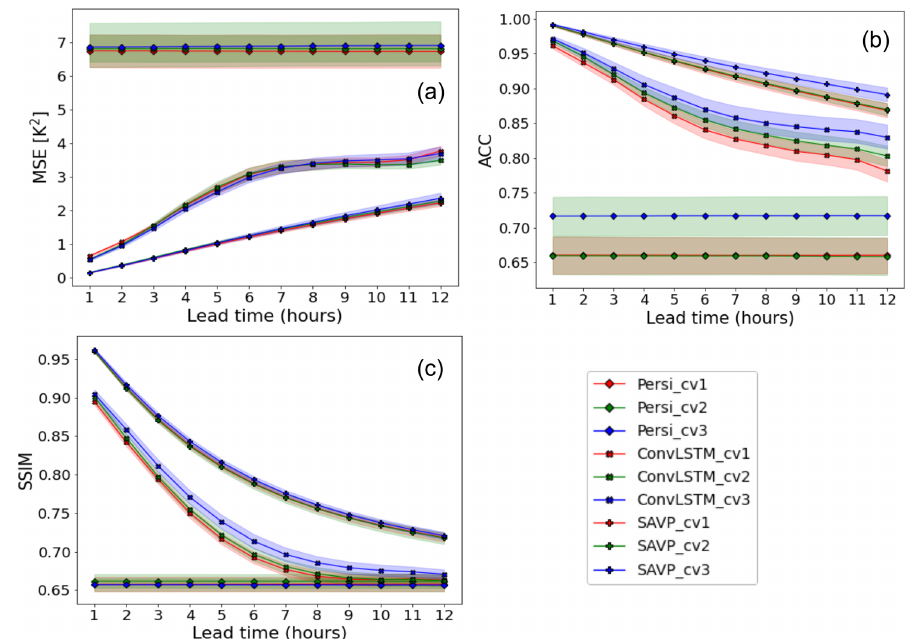
Figure C2. Averaged (a) MSE, (b) ACC, and (c) SSIM across lead time ( x axis) for the SAVP, the ConvLSTM, and the persistence fore- casts from Experiment 1 in Table A2. Like in Fig. 2, sampling uncertainty is estimated via block bootstrapping. However, the inter-decile confidence range is now colour shaded for the three cross-validation datasets using different models.